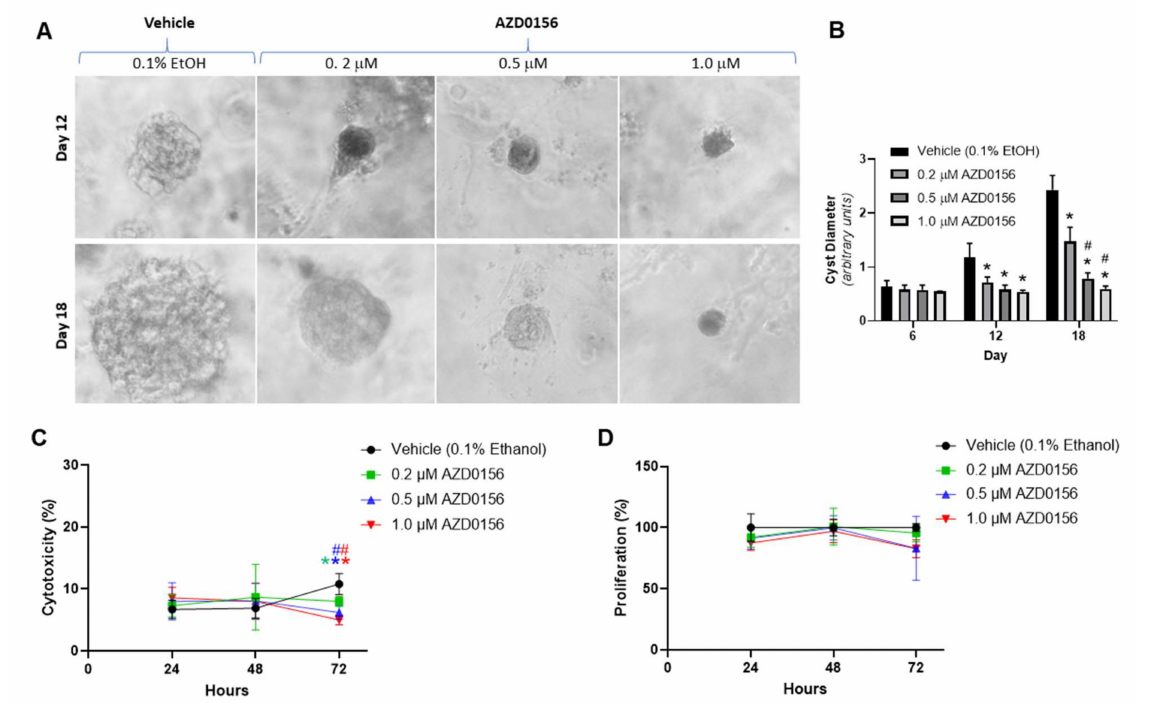
Figure 3. Effect of AZD0156 (ATM inhibitor) on in vitro cyst growth in human ADPKD cells. Human ADPKD cysts derived from WT 9-12 cells were treated with either vehicle [0.1% ethanol (EtOH)] or AZD0156 (0.2, 0.5, and 1 µ M) for 18 days. ( A ) Representative images of human ADPKD cysts treated with AZD0156 on Days 12 (upper panel) and 18 (lower panel) (Images were obtained using 10x objective). ( B ) Mean Cyst diameter on Days 6, 12, and 18 in the experimental groups. * p < 0.05 compared to vehicle, and # p < 0.05 compared to 0.2 µ M AZD0156. ( C ) Mean percentage cytotoxicity (measured using the LDH assay) and ( D ) Mean cell proliferation (measured by the BrdU assay) following treatment with either AZD0156 or vehicle. * p < 0.05 compared to vehicle and # p < 0.05 compared to 0.2 µ M AZD0156 (color of asterix/hash corresponds to the respective line color). All p -values in figure were determined by one-way ANOVA, followed by post hoc analysis with the Tukey–Kramer HSD test, and data presented as means ± SD ( n = 6 per